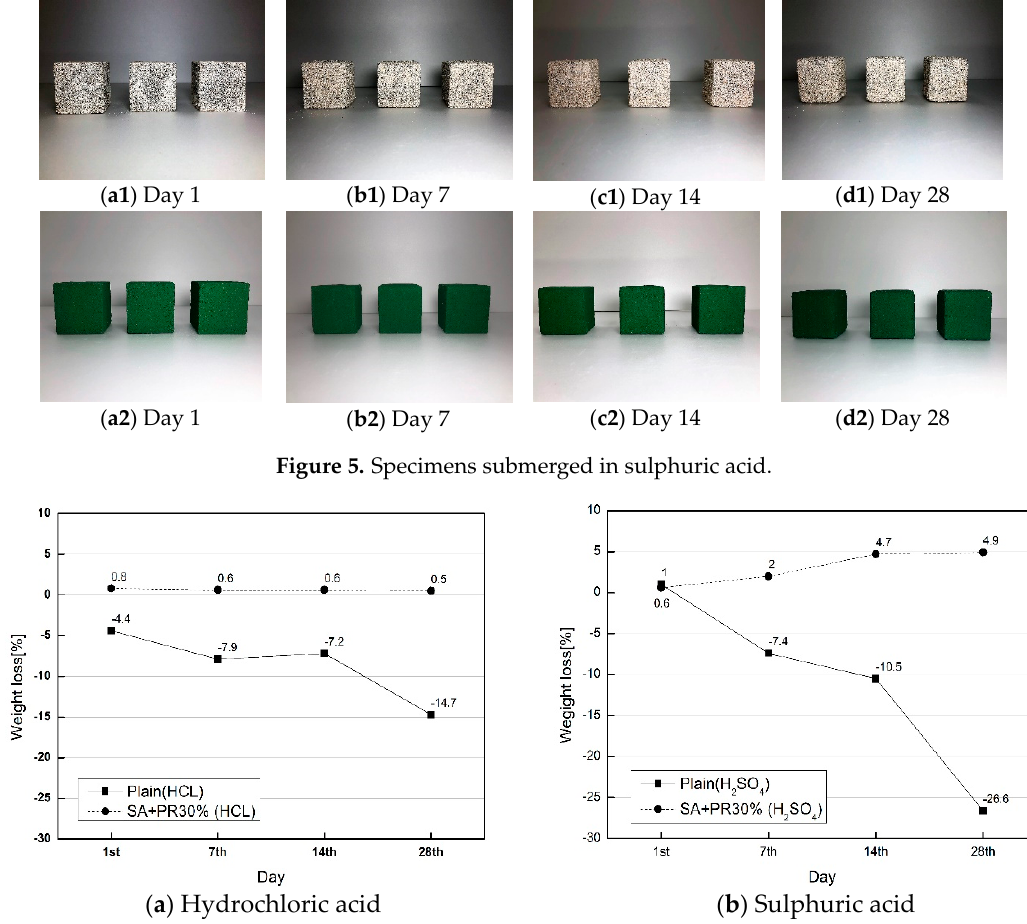
Figure 7. Chloride penetration measurement.